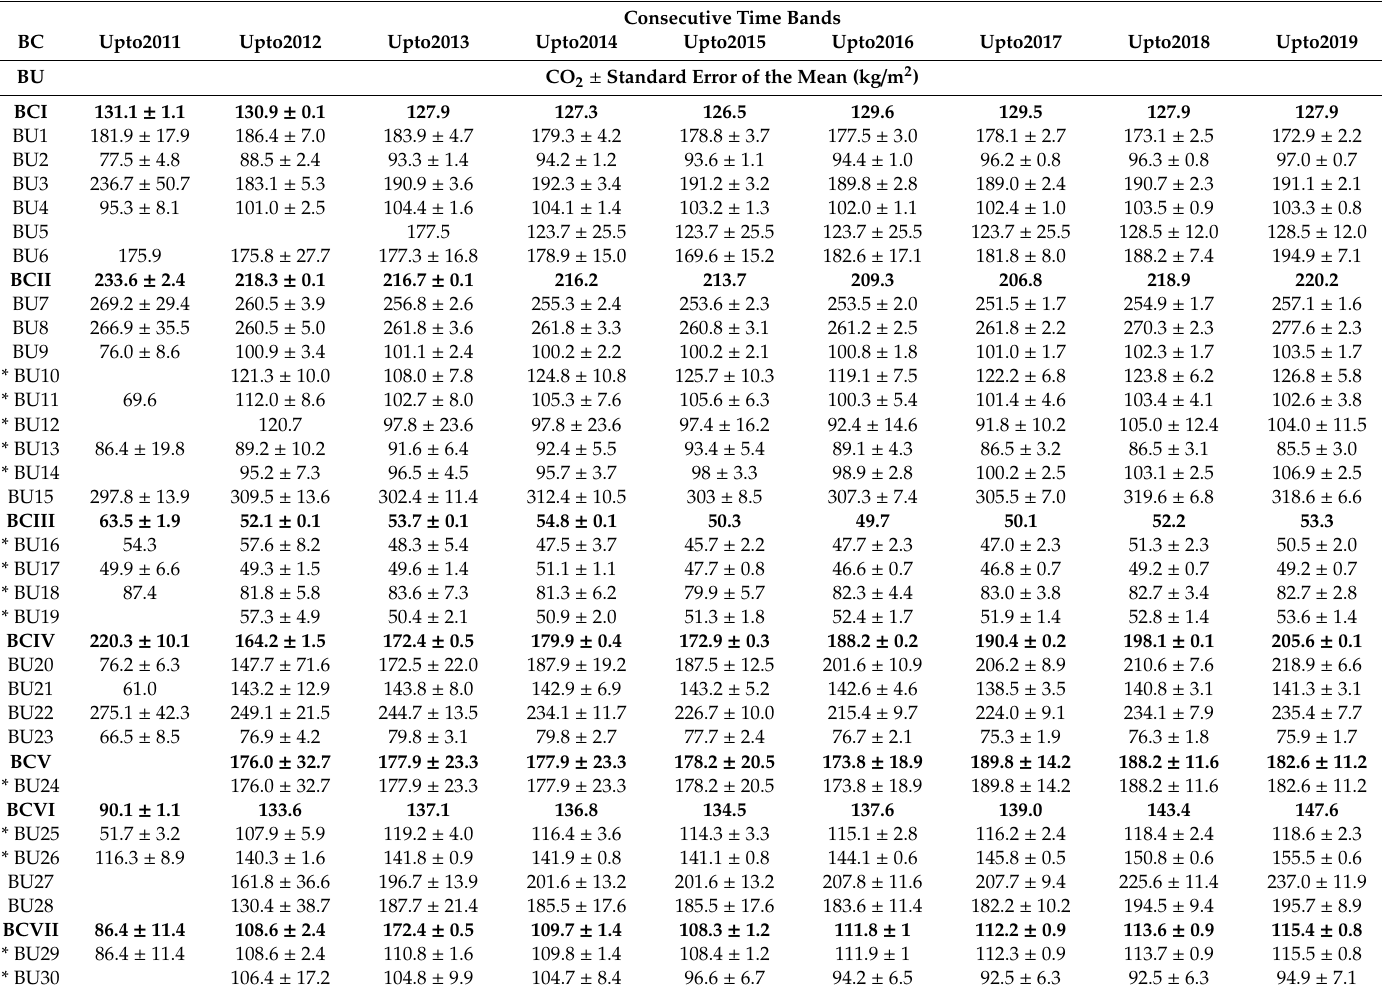
Table 7. Time evolution of calculated average CO 2 emissions intensity for the di ff erent building categories and building uses in the NR